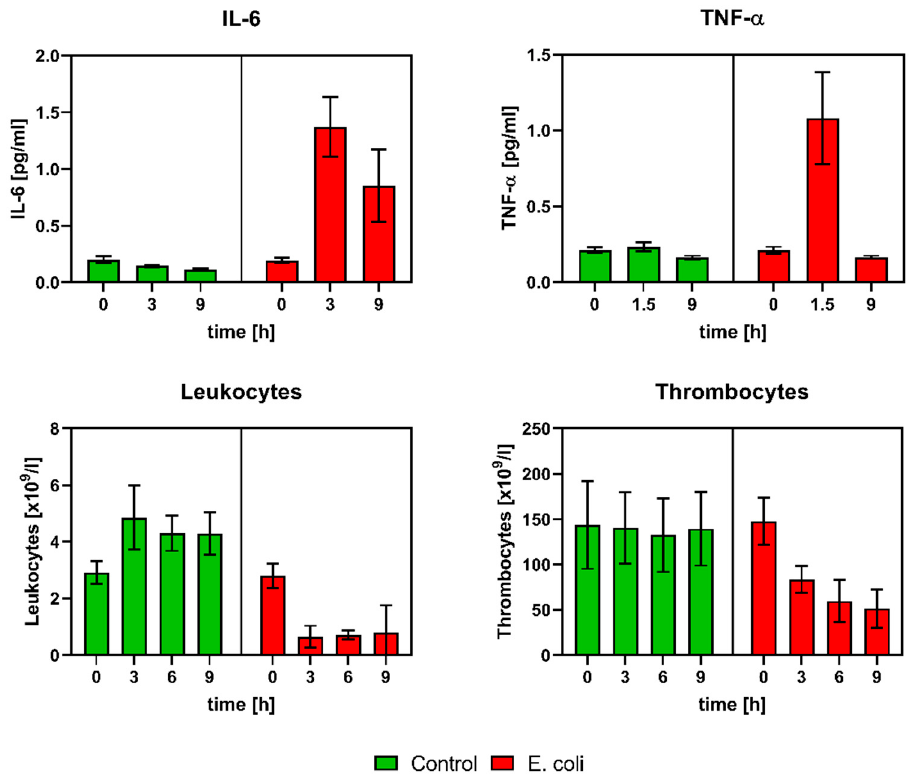
Figure 1. Development of inflammatory markers in animal blood against time for control (green, n = 6) and EC group (red, n = 6) (mean with corresponding 95%-CI). EC group shows an increase in inflammatory serum cytokines (IL-6, TNF- α ) and development of leukopenia and thrombocytope- nia.